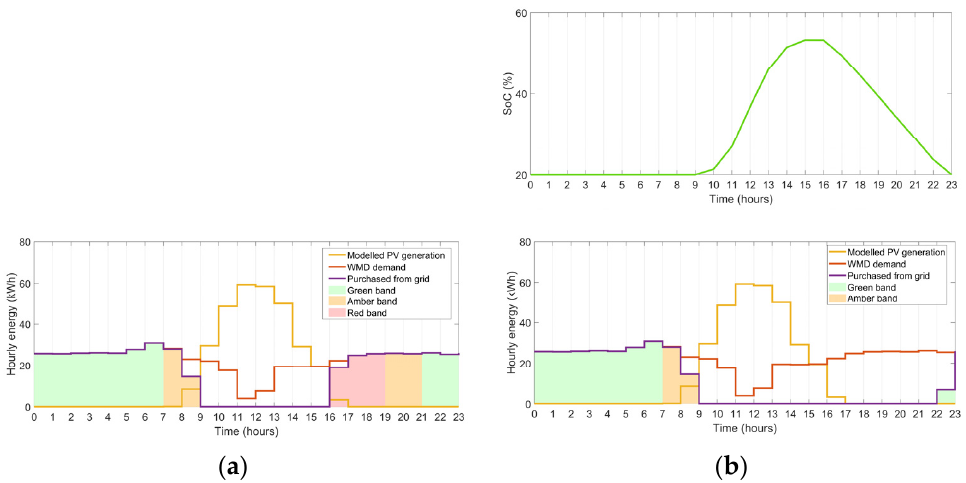
Figure 8. Comparison of the hourly energy consumption from the grid: ( a ) with only PV panels and ( b ) with PV panels and a BESS of 0.5 MWh (scenario 2).